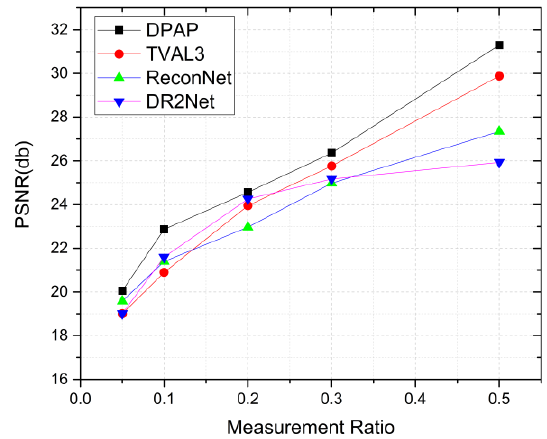
Figure 13. PSNR of test images with different algorithms at different measurement rates.